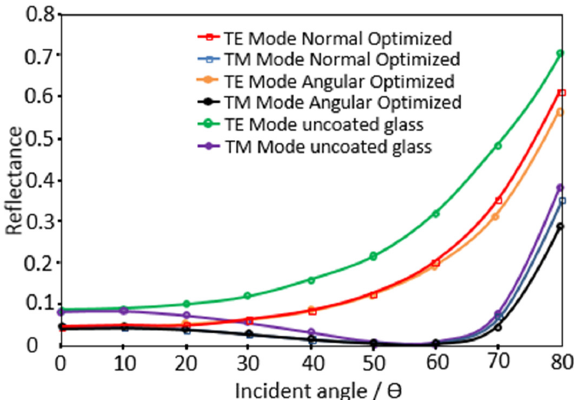
Figure 2. Two designs generated by G.A optimiz for 0° angle incidence ( A ), and 0–80° angle incidence ( B ). The first design follows a conventional index profile, while the second design has a thick low index third layer and a higher index fourth layer.